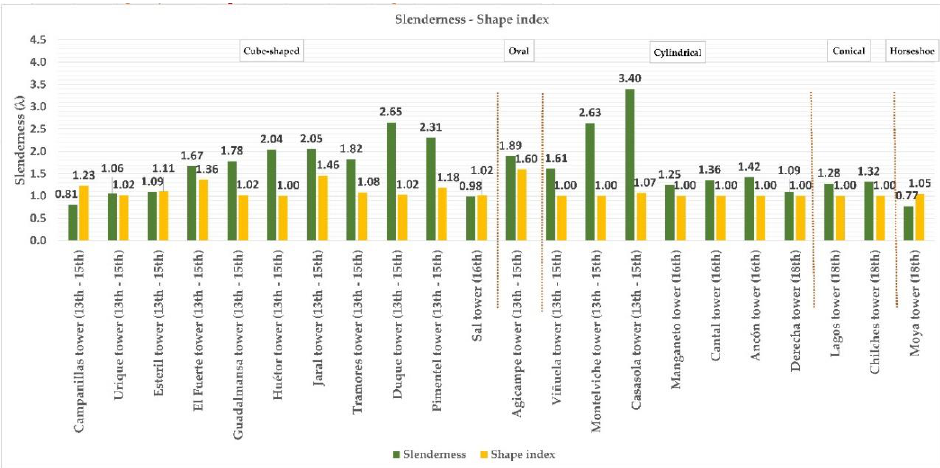
Figure 18. Slenderness and shape index for the towers under study.